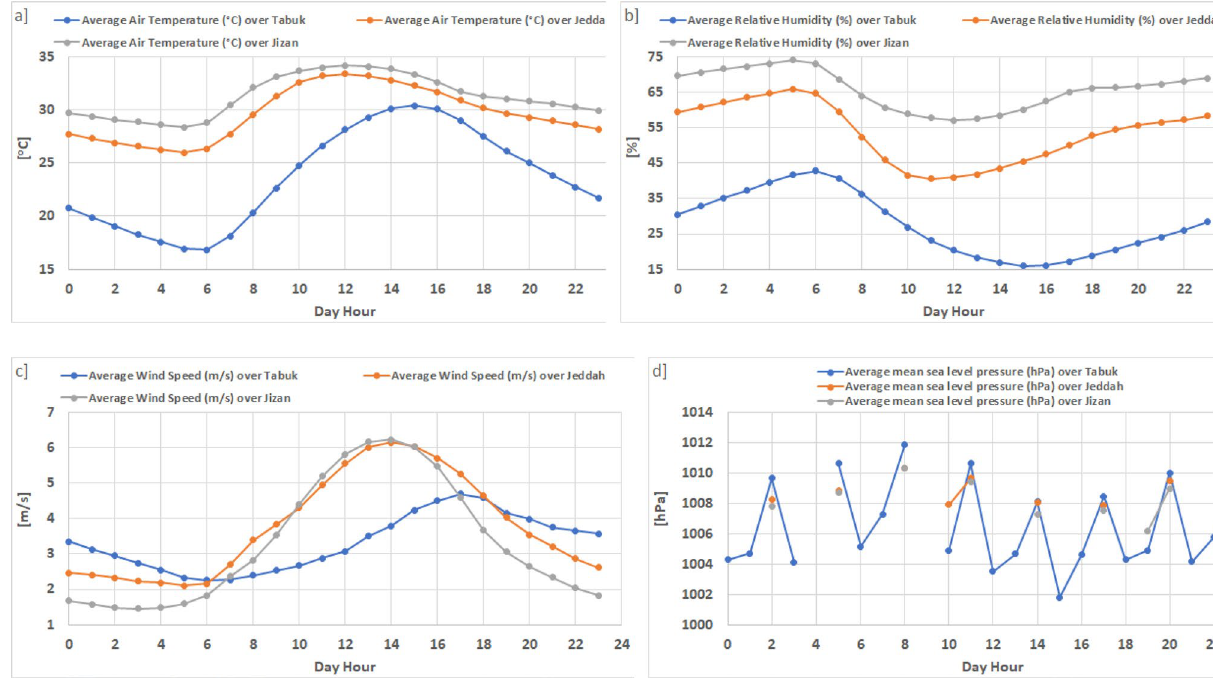
Figure 4. Observed short-term hourly means (daily cycle) for the parameters studied based on the hourly observed data (2016–2020) (there is a large gap in the mean sea level observation data for Jizan and Jeddah). Microsoft Office (Excel). Version 365. https:// www. office. com/.